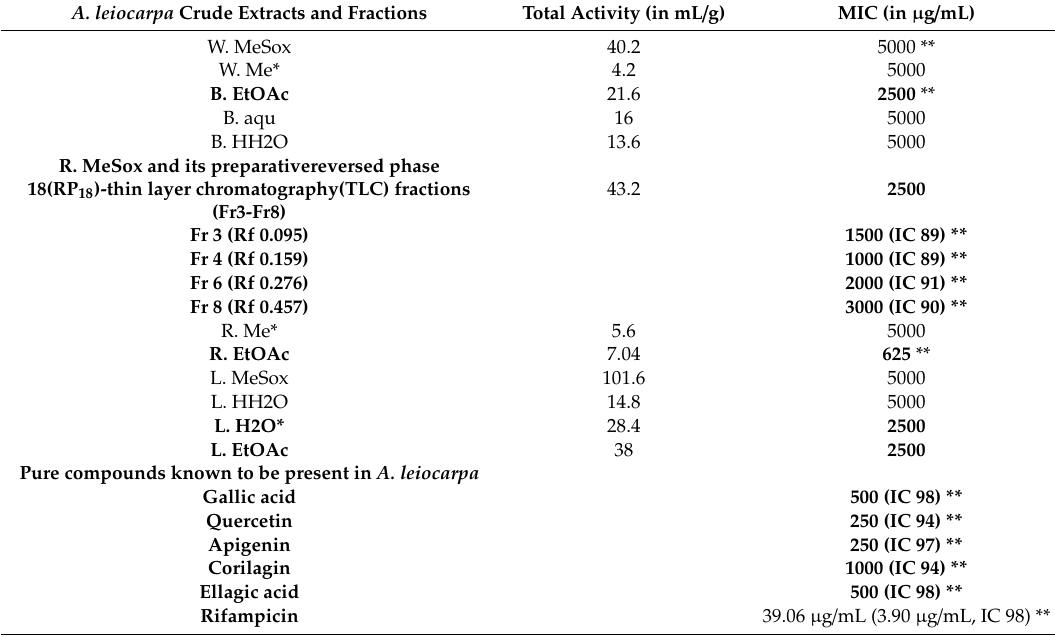
Table 2. Minimum inhibitory concentration of the extracts and fractions of A. leiocarpa against Mycobacterium smegmatis ATCC